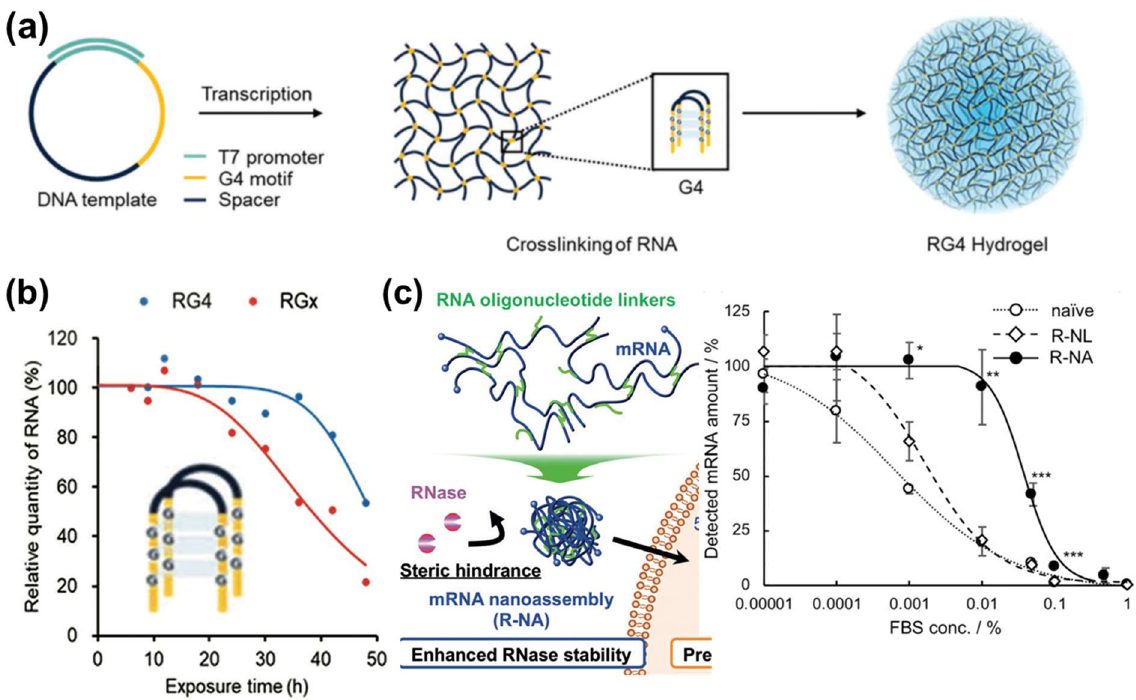
Figure 3. Construction of mRNA-NPs via manipulation of its sequence and evaluation of their stability; ( a ) scheme of the synthesis of free-standing protein-encoding hydrogel, reproduced with permission [52]; ( b ) relative quantity of RNA-G4 in blood serum, reproduced with permission [52]; ( c ) construction of linker-driven mRNA nanoassemblies (R-NA), their detected amount in FBS of various concentrations, and their remaining amount in mouse brain 4 h after injection. Reproduced with permission [54]. * p < 0.05, ** p < 0.01, *** p < 0.001.